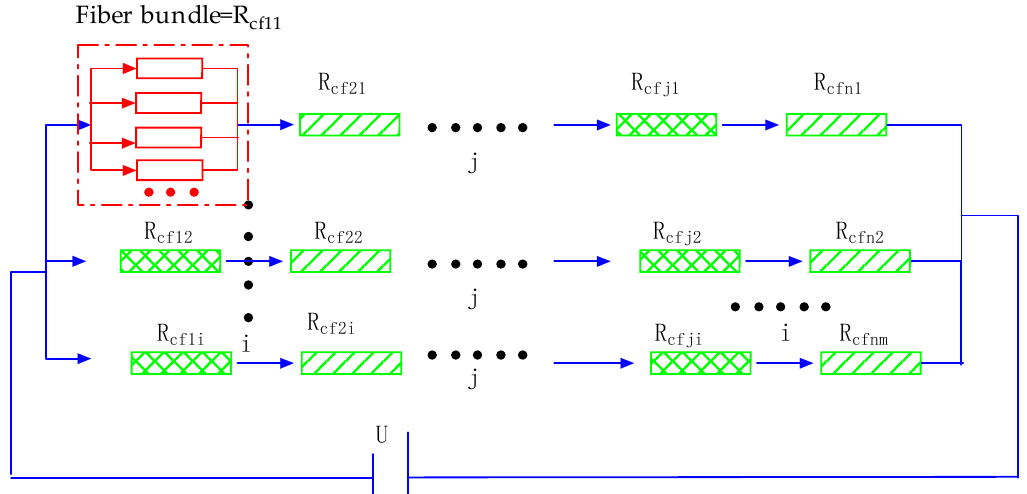
Figure 3. Connection of inner-adhesive-type CFRP: ( a ) operation process of CFRP bonded by adhe- sives; ( b ) fibre connection along the bond length; ( c ) fibre connection along vertical alignment.